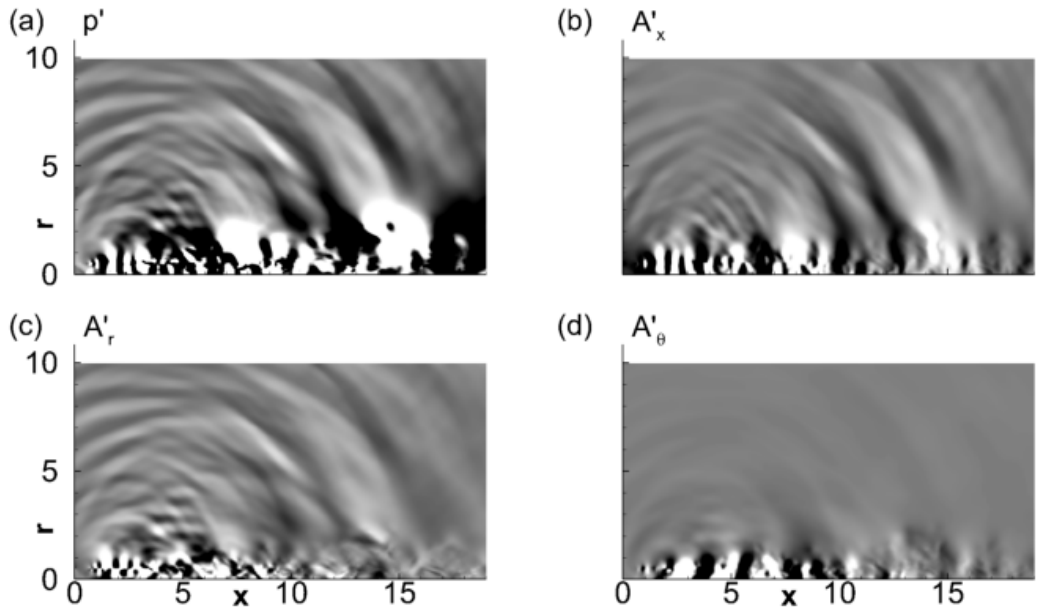
Figure 6. Instantaneous snapshots of ( a ) pressure perturbations; ( b ) axial; ( c ) radial and ( d ) azimuthal components of the acoustic mode. The axial extent of the contours begin from the nozzle-exit station, and the jet-flow direction is from left to right. Frames a , b , c and d share the same abscissa and